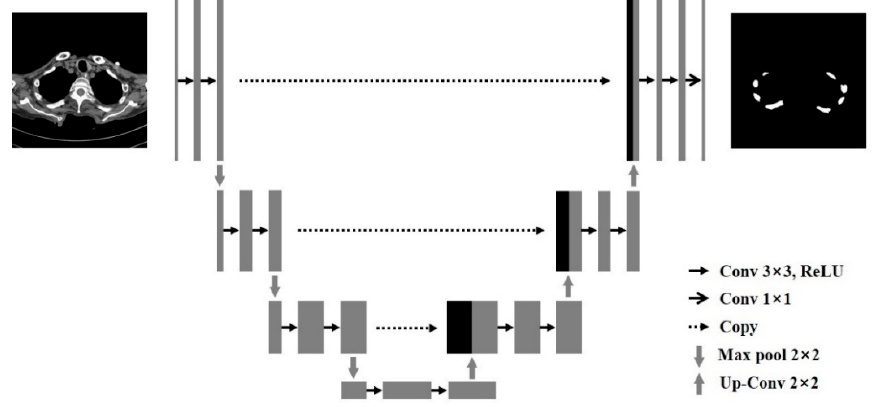
Figure 3. The architecture of U-net .